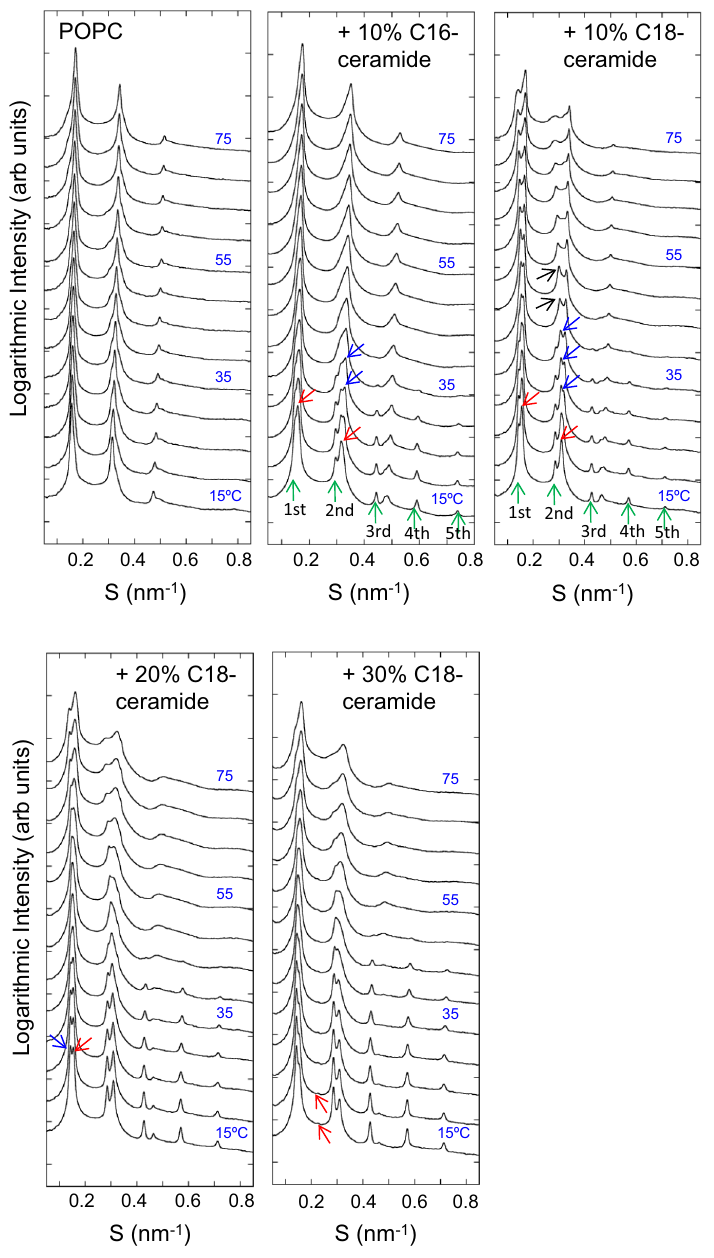
Figure 2. Small-angle X-ray scattering (SAXS) profiles obtained from POPC, POPC/10% C16-ceramide and POPC/C18-ceramide containing different amounts of C18-ceramide (10, 20, 30 mol%). Data were taken from 15 to 75 °C at 5° interval. All samples (150 mM final lipid concentration) were dispersed in 20 mM HEPES buffer (pH 7.0) containing 100 mM NaCl and 10 mM